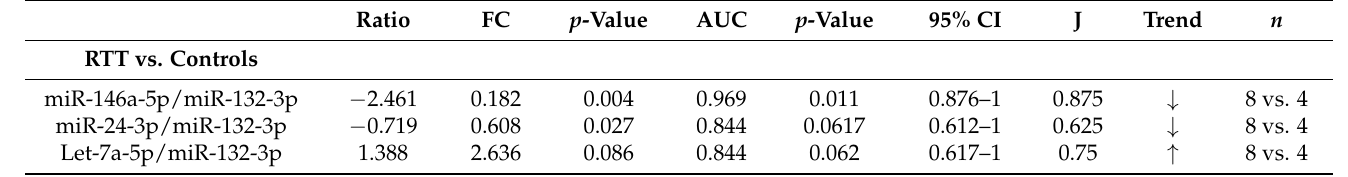
Table 6. Validation of potential miRNA biomarkers for RTT in fibroblasts primary cultures.